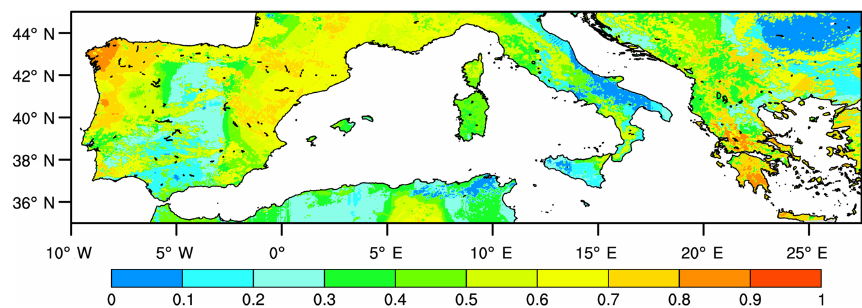
Figure 7. Geographical distribution of the static probability of exceedance for the threshold of 2000GJ.